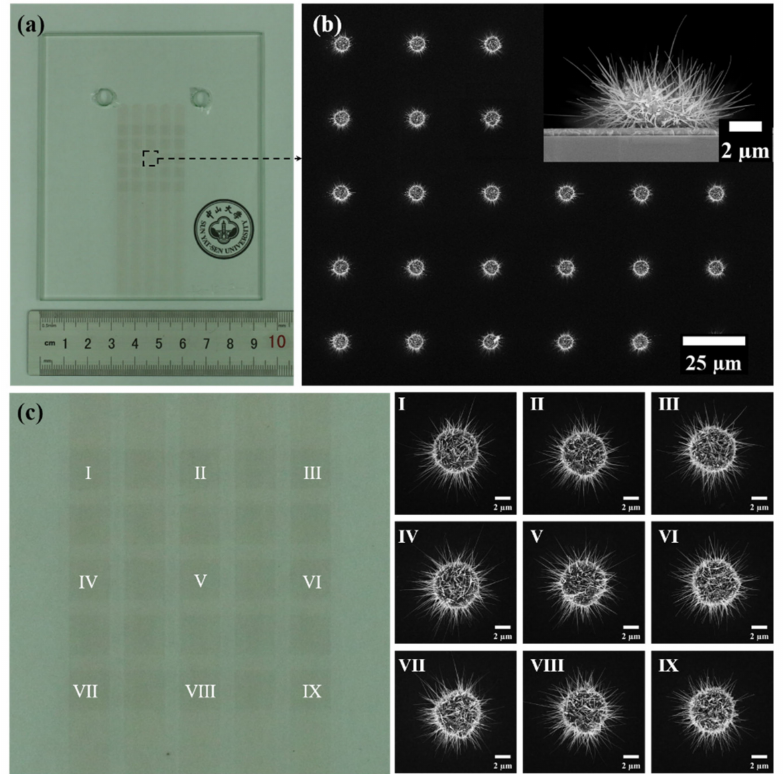
Figure 3. ( a ) Optical photograph of the cathode panel; ( b ) top view and cross-sectional view SEM images of the central pixel; ( c ) top view SEM images of 9 single patterns chosen from different areas.